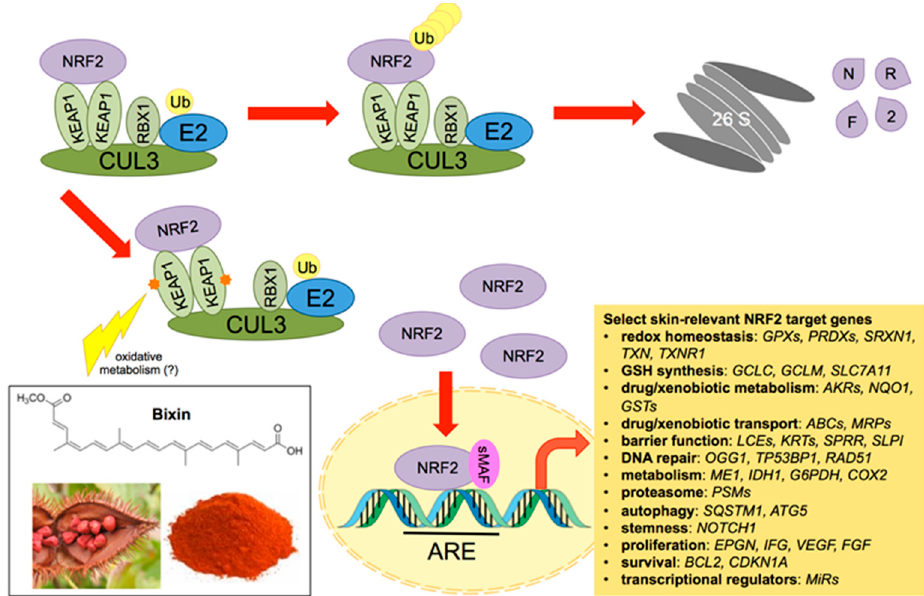
Figure 1. The nuclear factor-E2-related factor 2 (NRF2) pathway with a focus on skin barrier function and environmental stress protection. The transcription factor NRF2 binds to Kelch-ECH associated protein 1 (KEAP1), the substrate adaptor protein for the cullin 3-RING box protein 1 (CUL3-RBX1) E3 ubiquitin ligase complex. Under basal conditions, NRF2 is ubiquitylated and degraded by the 26S proteasome. Upon modification of reactive cysteines in KEAP1 by reactive oxygen species (ROS) and electrophiles (including bixin), NRF2 is no longer ubiquitylated. This allows for newly synthesized NRF2 to accumulate, translocate to the nucleus, and activate the transcription of antioxidant response element (ARE)-containing target genes by dimerizing with small MAF (sMAF) proteins. Select skin-relevant NRF2 target genes are displayed according to the cellular function they perform. GPXs , glutathione peroxidases; PRDXs , peroxiredoxins; SRXN1 , sulfiredoxin 1; TXN , thioredoxin; TXNR1